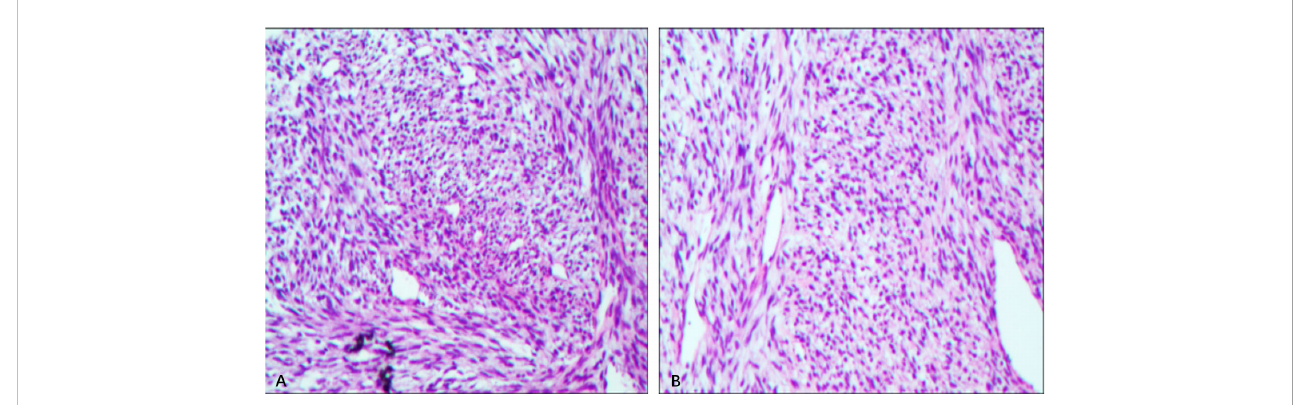
FIGURE 2 Histological sections revealing monotonous spindle cell proliferation, necrosis or mitotic fi gures found. (A, B) Histologic image of leiomyoma. (H&E, ×